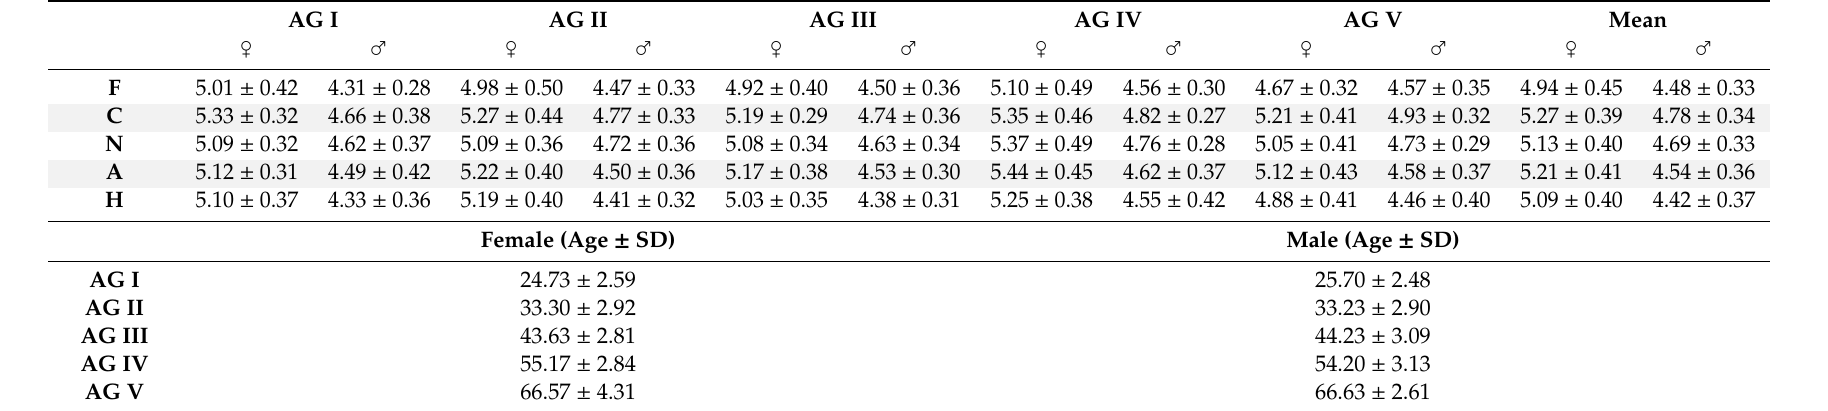
Table 1. Mean values (MV ± SD) arranged by age groups and localization (adapted from [26]).